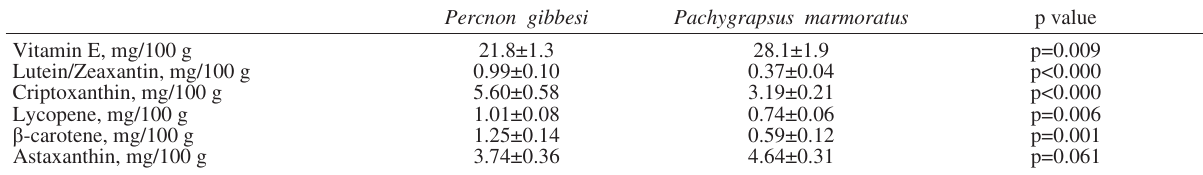
Table 2. – Antioxidant enzyme activities and malondialdehyde (MDA) concentration determined in hepatopancreas of Percnon gibbesi (n=14) and Pachygrapsus marmoratus (n=14) captured in Portals Vells (Mallorca, Balearic Islands, western Mediterranean by apnoea divers. Sig- nificant differences were analysed with one-way ANOVA. Values are expressed as mean±SEM and p<0.05 was considered statistically significant. Percnon